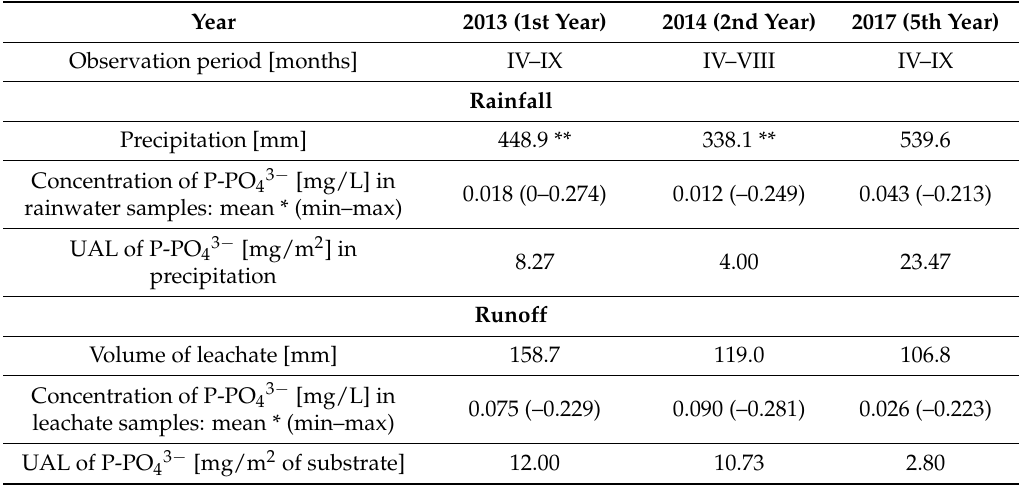
Table 4. Experimental data of long-term open air green roof